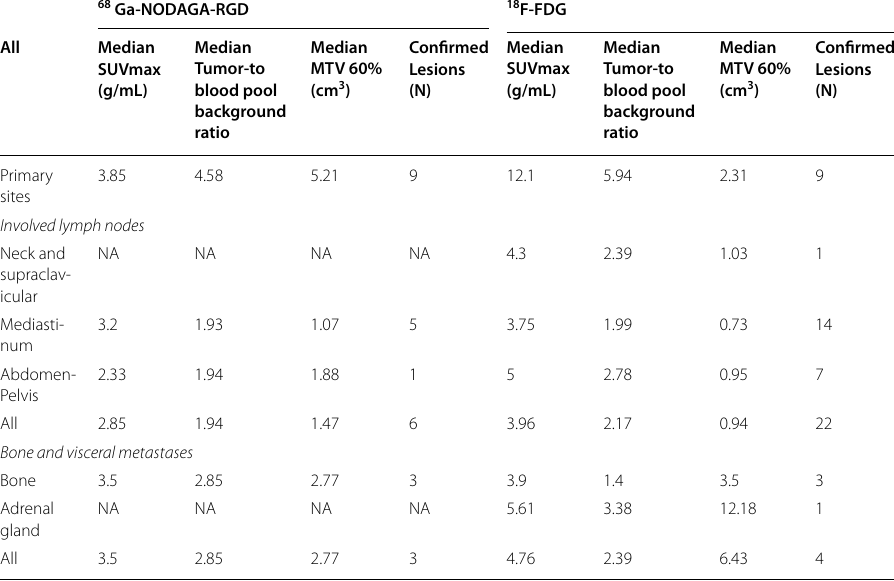
Table 3 Measurements of 68 Ga-NODAGA-RGD or 18 F-FDG uptake in confirmed positive